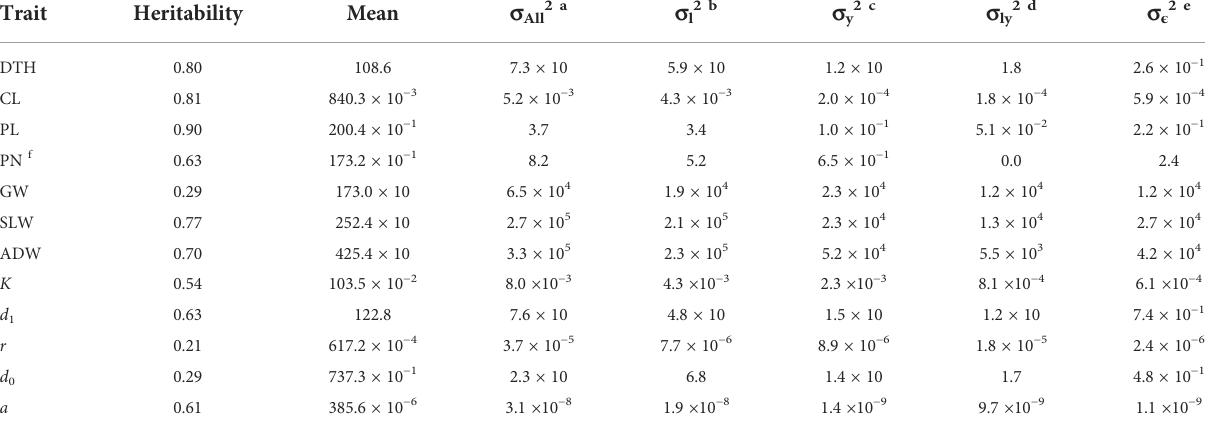
TABLE 2 Summary statistics of CH-related parameters and traits obtained by the linear mixed effects model.